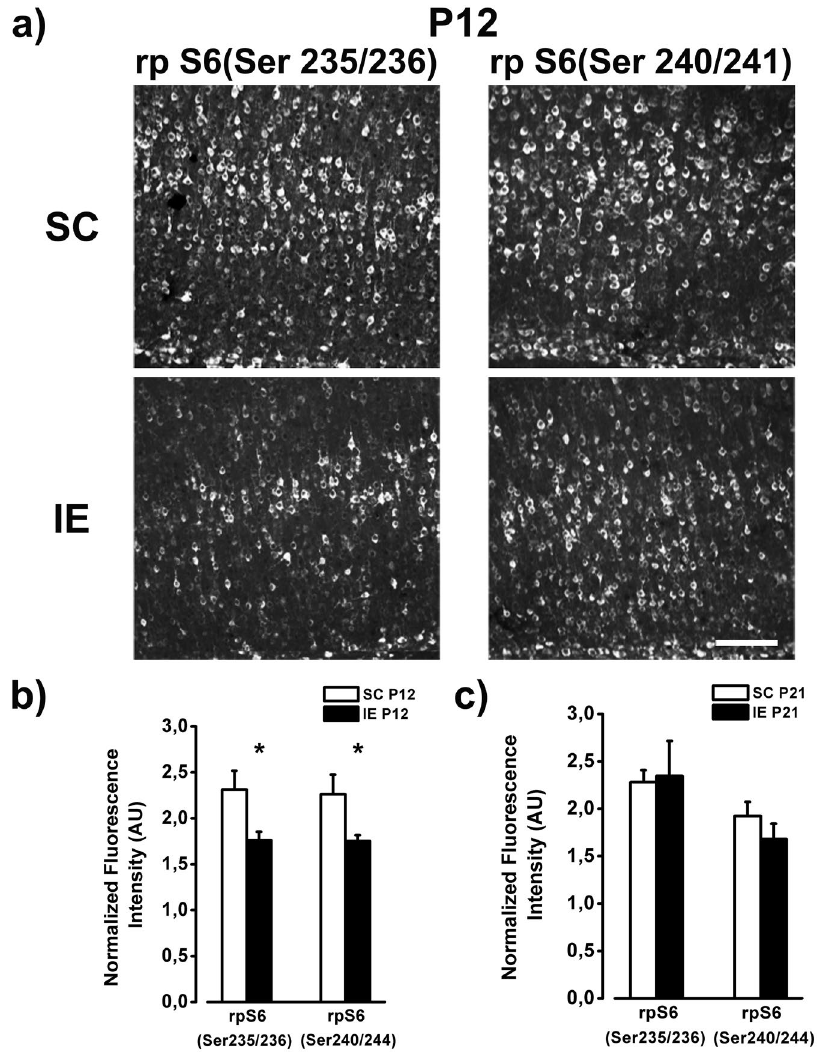
Figure 7. Hypophosphorylation of rpS6 in IE brain. ( a ) Example of rp S6 labeling (Ser235/236 and Ser 240/241) from fields taken in the layers V/VI of the visual cortex of P12 SC and IE rats. Calibration bar: 100 µm. ( b ) Quantitative analysis of rp S6 immunofluorescence intensity in the visual cortex of P12 animals. SC animals showed higher rpS6 expression in comparison to IE animals both for the site Ser235/236 and for the site Ser240/244 (SC P12, n = 5; IE P12, n = 5, Two way ANOVA, post-hoc Holm-Sidak method, p < 0.05). ( c ) At P21 rp S6 expression did not differ between SC and IE animals (SC P21, n = 5; IE P21, n = 6; p = 0.48). Histograms represent average values ± SEM. * p <